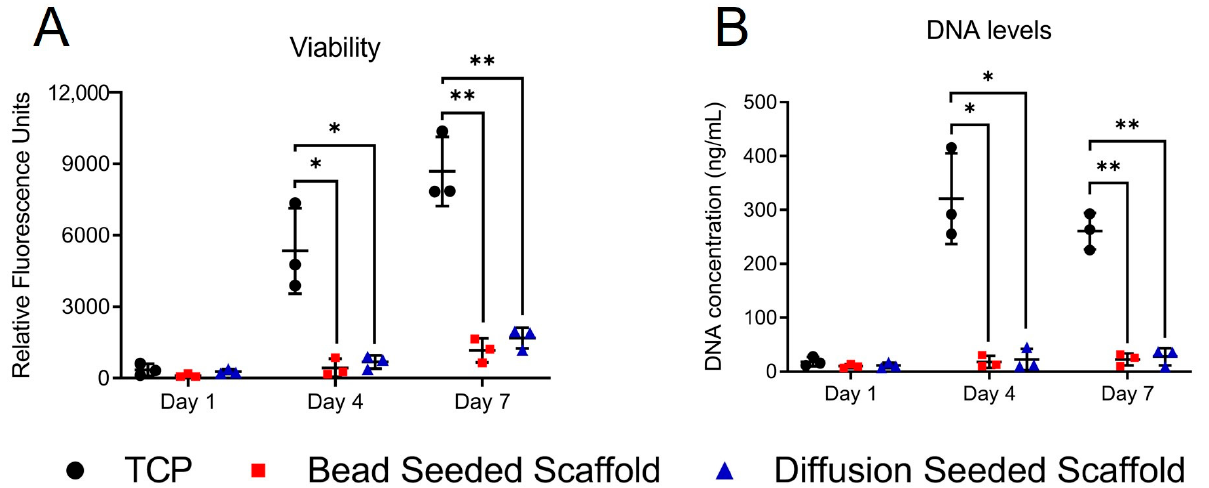
Figure 2. PrestoBlue™ and PicoGreen™ assay data using 3T3 fibroblasts. ( A ) PrestoBlue Viability data ( B ) PicoGreen data. Fluorescence and absorbance were read using a Tecan M200 plate reader and Magellan analysis software. GraphPad Prism software was used to generate graphs. ** p < 0.01, * p < 0.05. Error bars represent the standard error, (biological replicates = 3, technical replicates = 3).